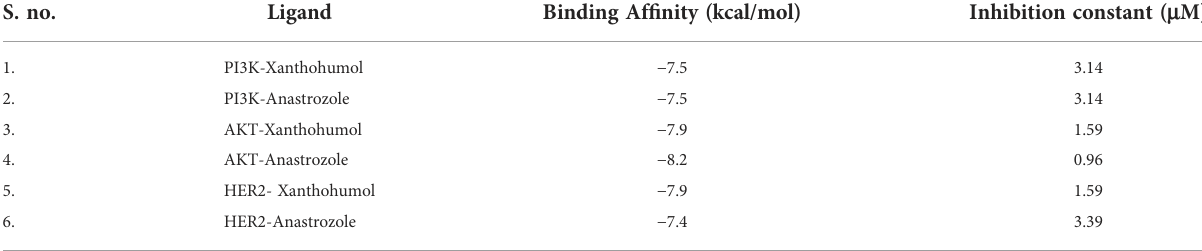
TABLE 2 Representation of binding af fi nity and RMSD upper and lower